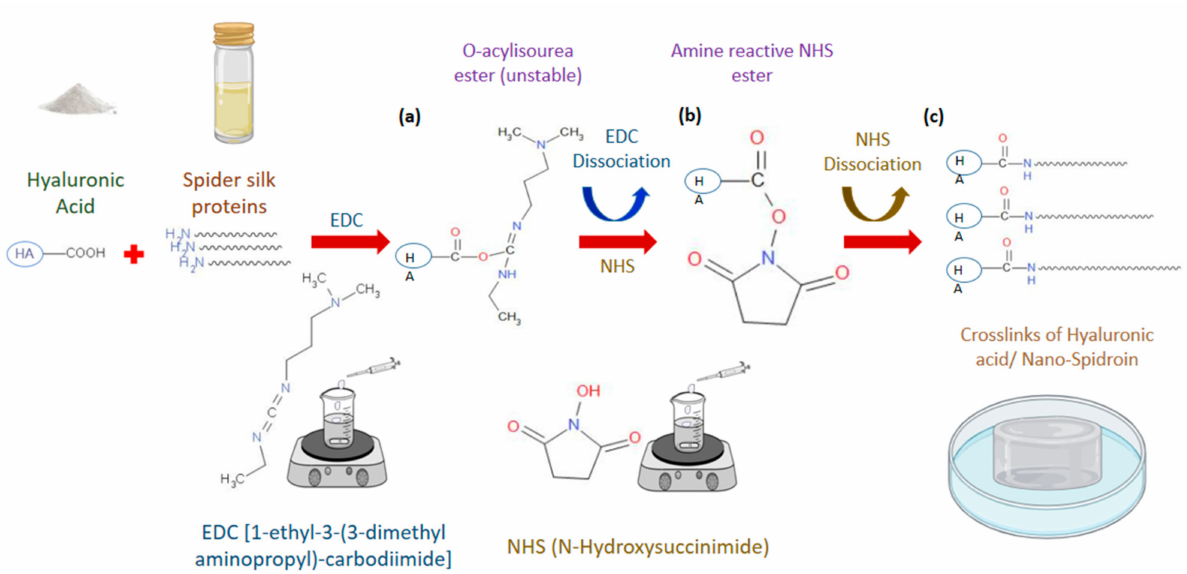
Figure 2. Schematic mechanism of the synthesis of hyaluronic acid/ spider silk-based hydrogels by EDC (1-ethyl-3-(3- dimethyl aminopropyl)-carbodiimide/ NHS (N-Hydroxysuccinimide) crosslinking (pH = 4.5–5.5). ( a ) EDC reacts with the carboxylic groups to produce unstable O-acylisourea intermediate. ( b ) NHS directly dissociates EDC, leading to the formation of amine reactive NHS ester. ( c ) The highly reactive NHS ester directly binds with amine groups in the spider silk, leading to the production of a crosslinked hydrogel